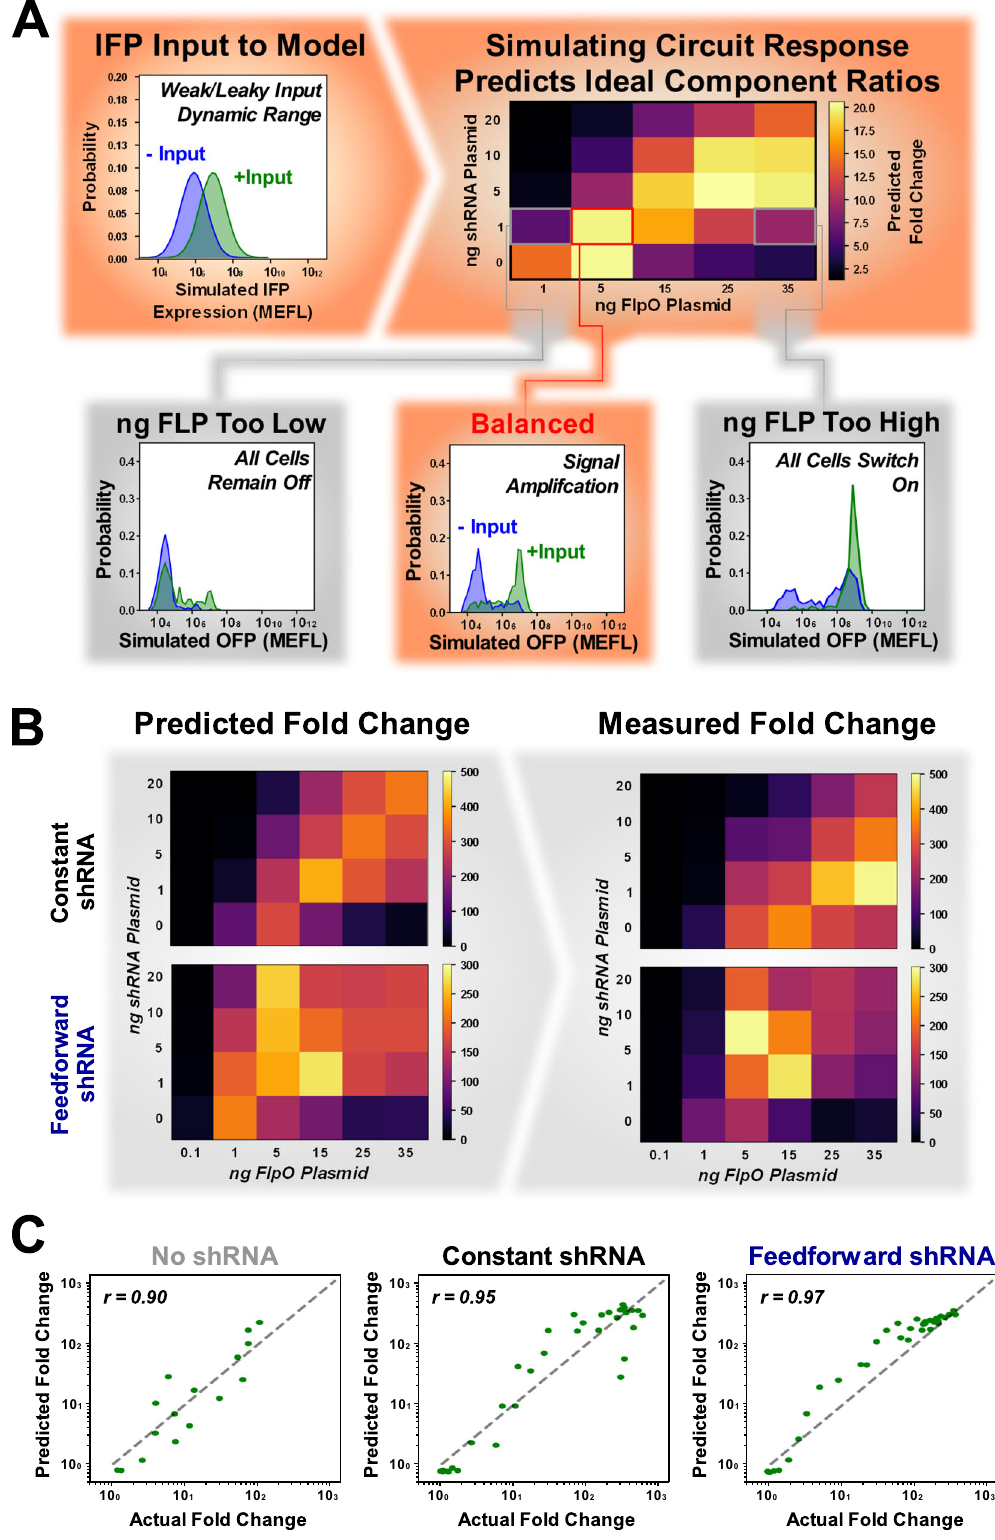
Fig. 3 Model fi t to dose response data predicts time-series data for multiple topologies. A Flow chart of modeling signal ampli fi cation predictions and how these can be mapped back to fi nd optimal Flp:shRNA ratios given a particular input signal. B Heatmaps highlighting the trends in digitizer fold change demonstrate similar trends between predicted (left) and experimentally observed (right) values for each topology. C Scatter plots of predicted versus actual fold change between plus/minus DOX conditions for each of our three systems at 48 h post transient transfection/induction. Each point represents a different recombinase:shRNA ratio. Number of ratios in each plot is n = 16, n = 36 and n = 36 for the No shRNA, Constant shRNA, and Feedforward shRNA respectively. Pearson correlation coef fi cient (r) shown at top left of each